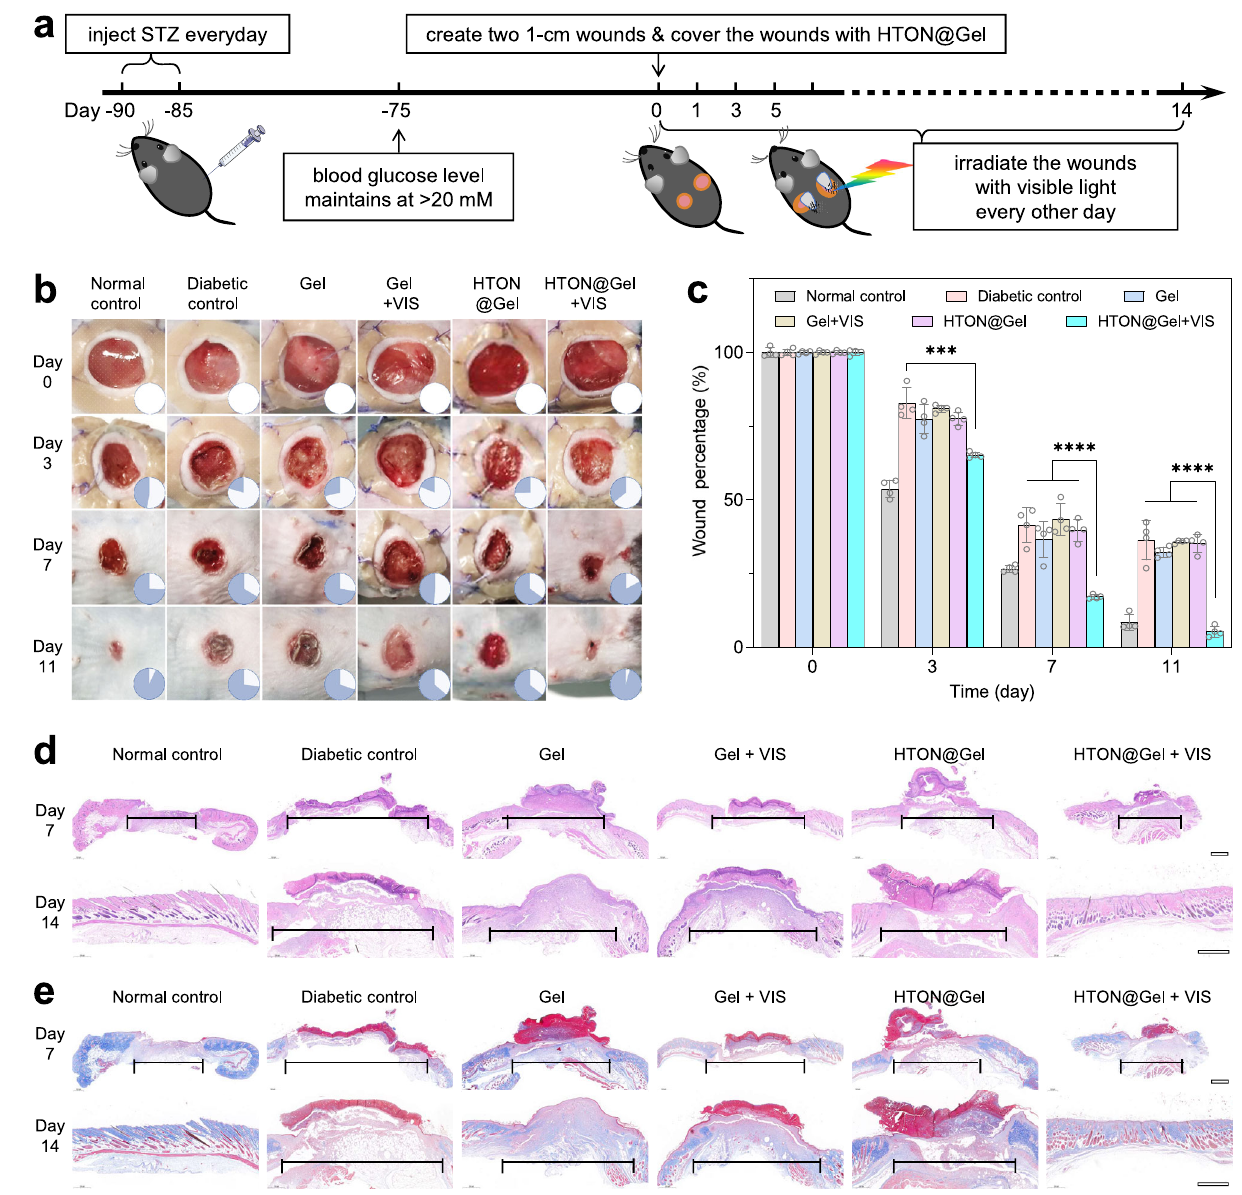
Fig.5|InvivoperformancesofphotocatalytictherapywithHTON. Thediabetic wound model building and the treatment procedure with HTON@Gel ( a ), the digitalimagesofdiabeticwounds( b )andthecorrespondingwoundsizestatistic( c ) during treatment ( n =5 biologically independent samples), hematoxylin-eosin (H&E)( d )andMasson ’ strichrome( e )stainingimagesofwoundtissuesextractedat